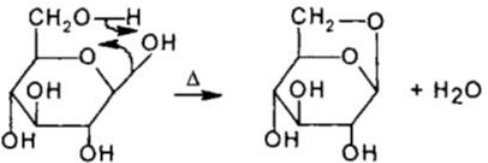
Figure 9. The formation of levoglucosan.